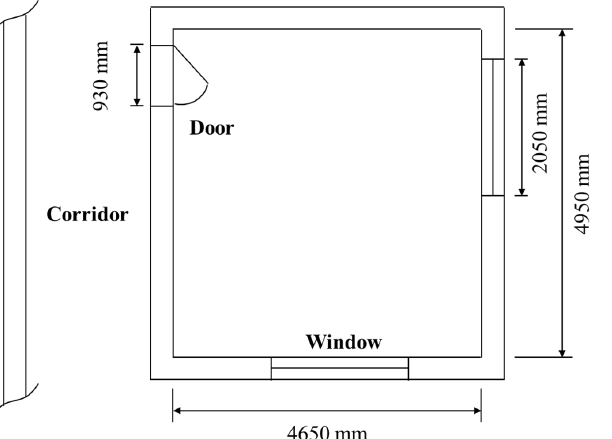
Figure 3. Layout of the measured room.